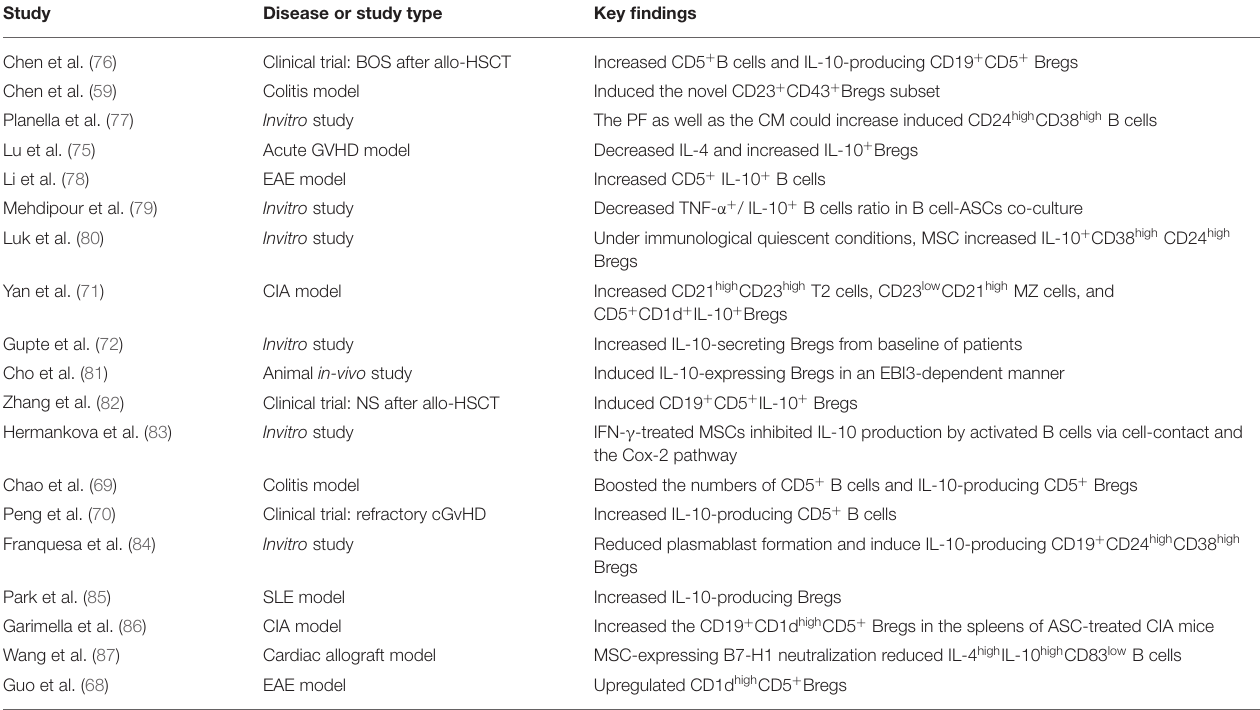
TABLE 2 | Summary of the studies on MSC-mediated effects to